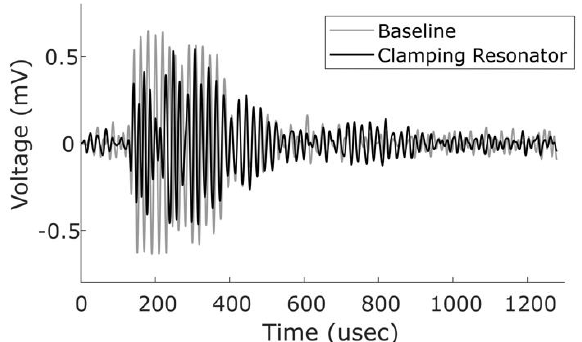
Figure 5. A-scans measured 69 cm from the transmitting transducer. The A-scan (black) from the plate with clamping resonators has a reduced amplitude around 200 µs when compared to the baseline (grey). These A-scan examples were some of the noisier signals that were measured.